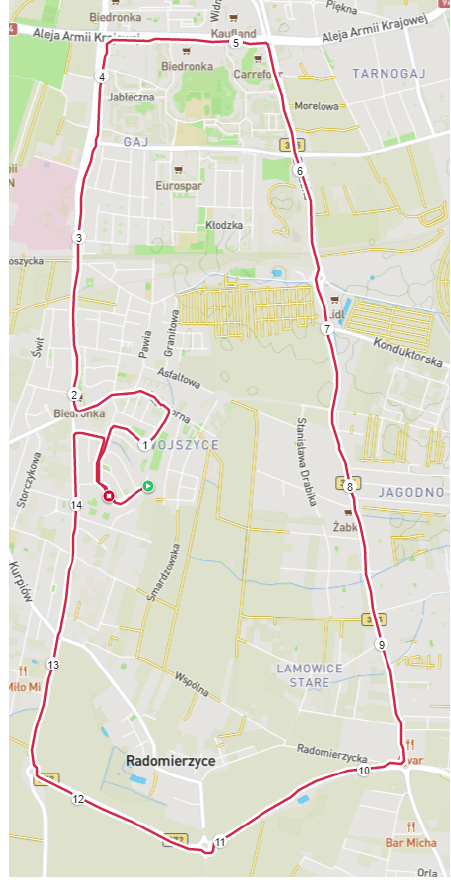
Figure 1. Route used for testing (numbers denote consecutive kilometers on the